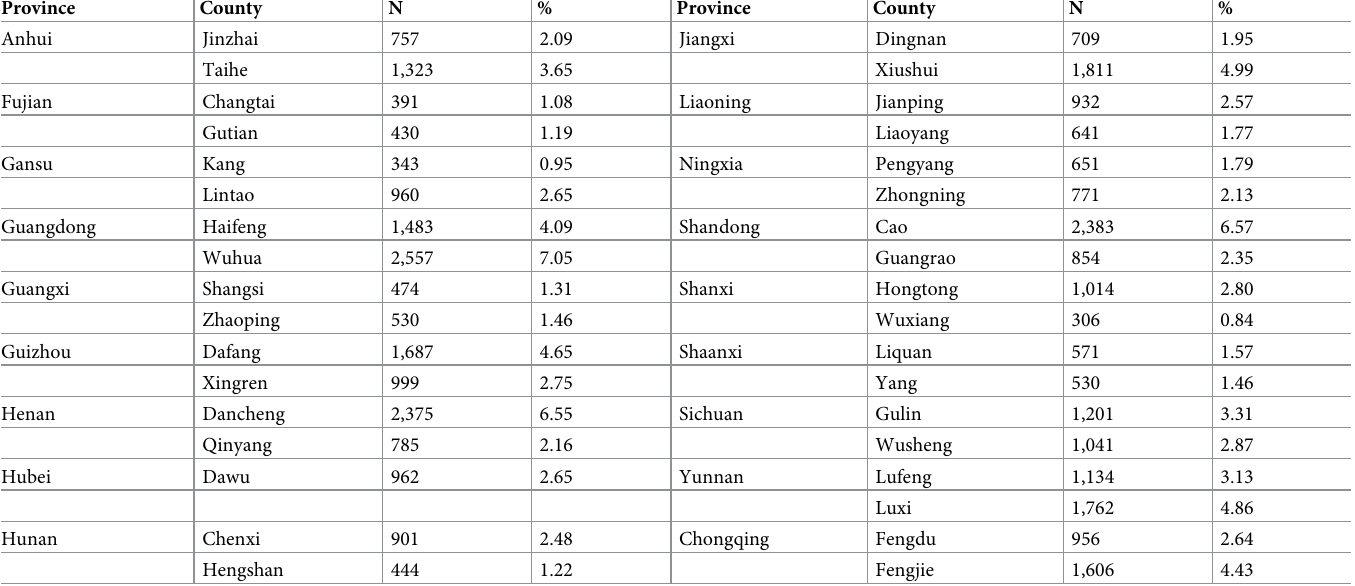
Table 2. Geographical distribution of the teacher